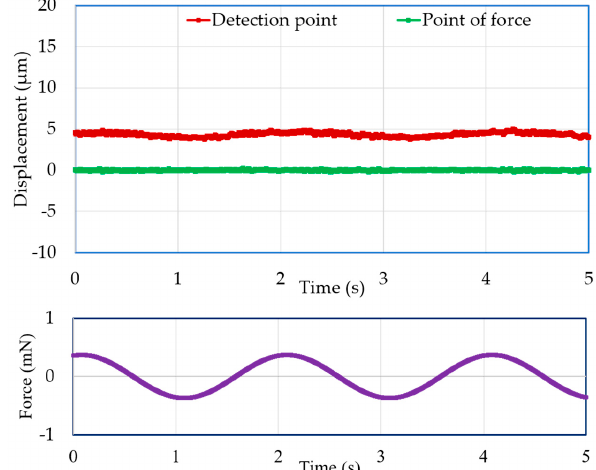
Figure 14. Displacements of the point of force and detection point with a dynamic force of 555 μ N and a 0.5-Hz frequency.